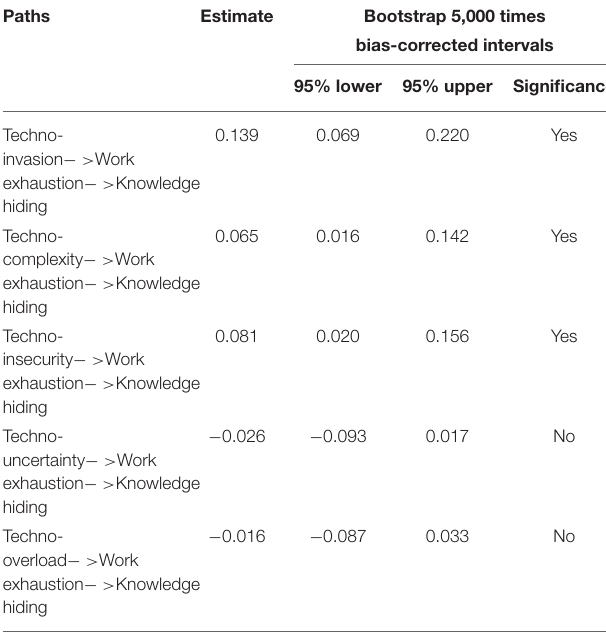
TABLE 7 | Hypothesized direct effects ( N = 254). TABLE 8 | The indirect effect of hypothesized paths ( N =